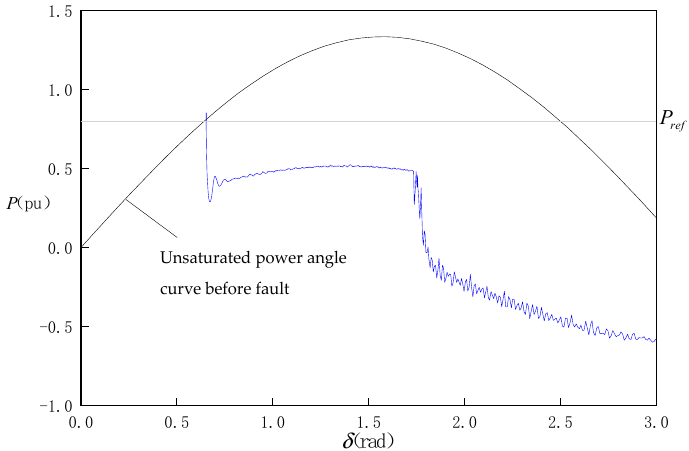
Figure 15. Simulation results of deep voltage sag while X Σ is 0.16 pu.